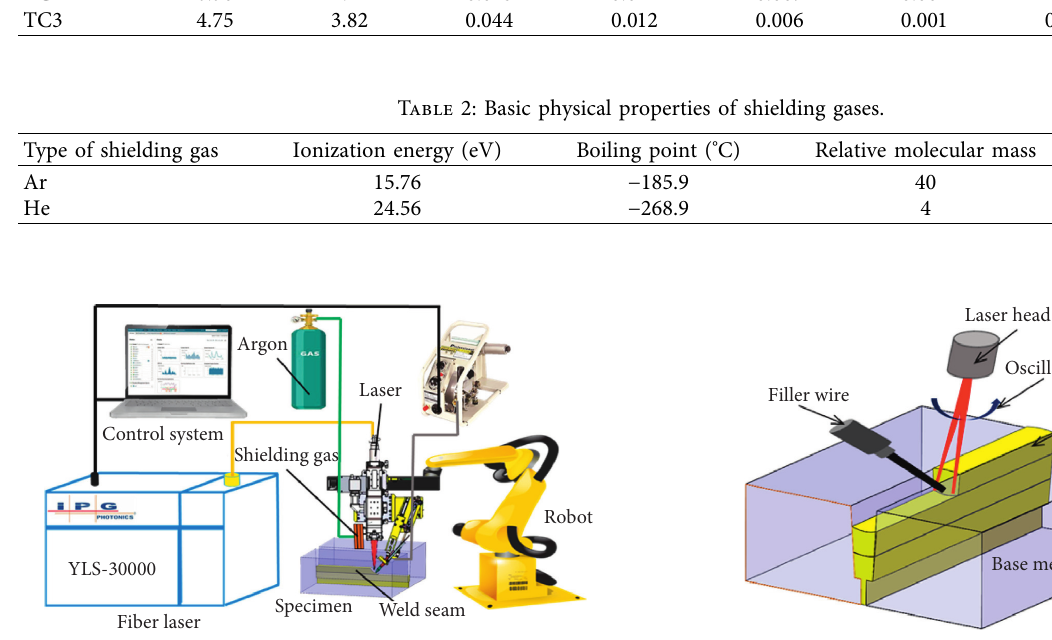
Figure 2: The system of laser welding with filler wire.